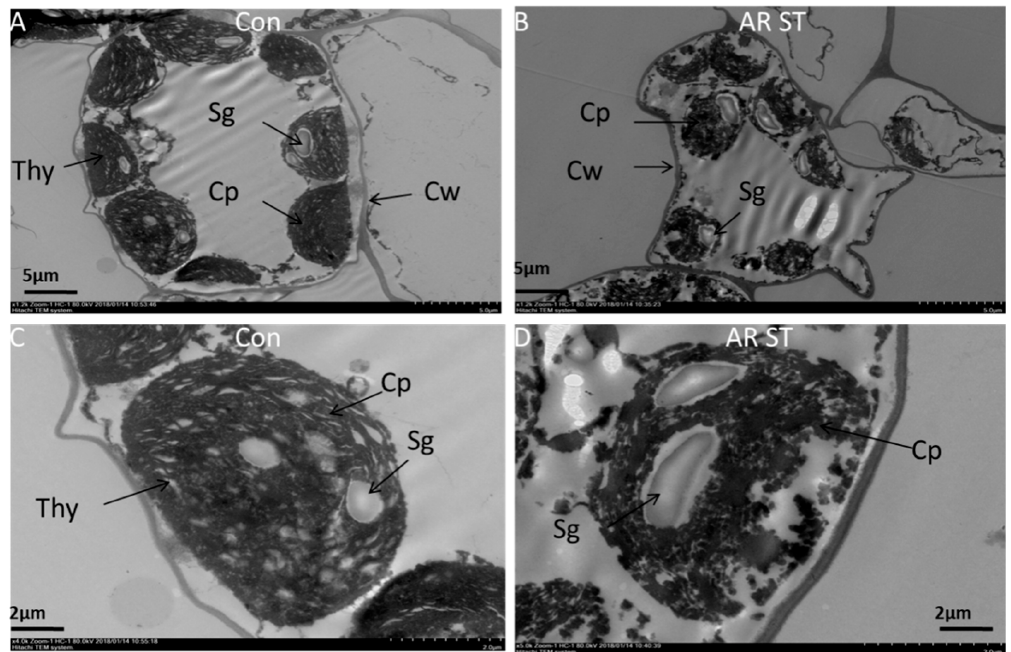
Figure 1. Ultra-structures of mesophyll cells of the middle part of midrib of the tomato leaf through transmission electron microscopy (TEM). ( A , B ) figures show TEM structure of whole leaf mesophyll cell of control and acid rain (AR)-stressed (AR-ST) tomato leaf, respectively. ( C , D ) figures show a relatively low magnified view of mesophyll cell of control (Con) and AR-stressed (AR-ST) tomato leaf, respectively. CP, Chloroplast; CW, Cell wall; Thy, Thylakoids; Sg, Starch grana